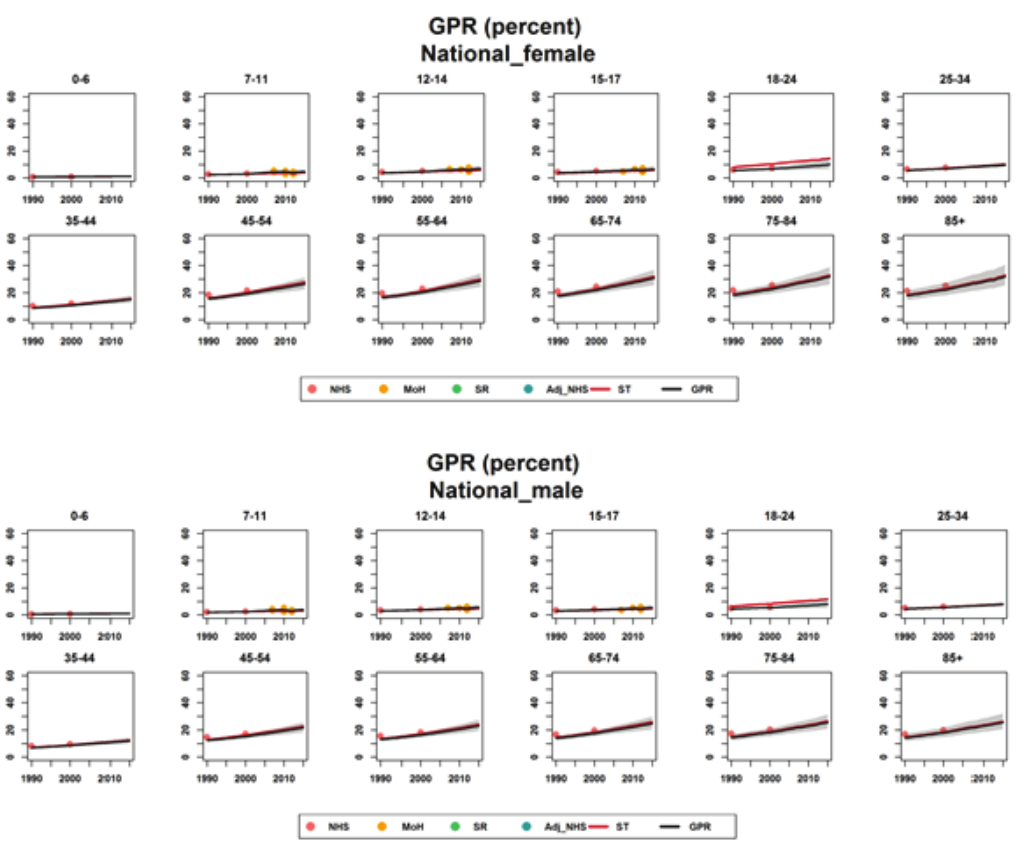
Figure 3. Trend of refractive errors prevalence at national level by sex and age groups from 1990 to